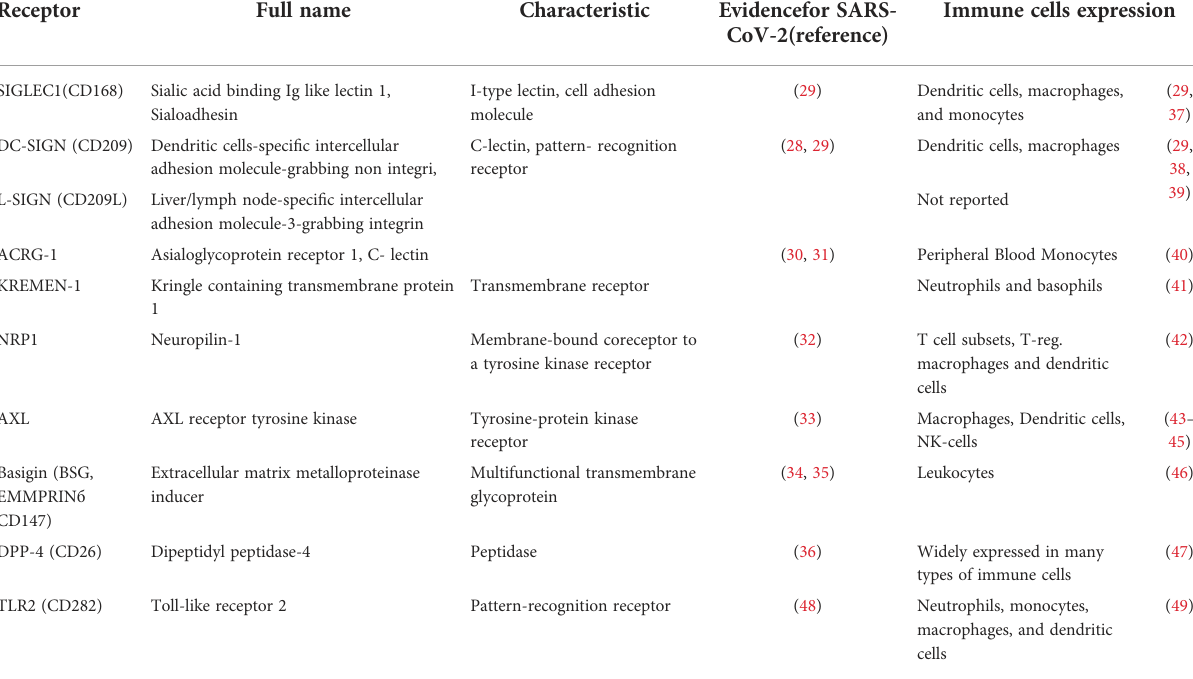
TABLE 1 Potential receptors and co-receptors for SARS-CoV-2 entry into immune cells other than ACE-2.